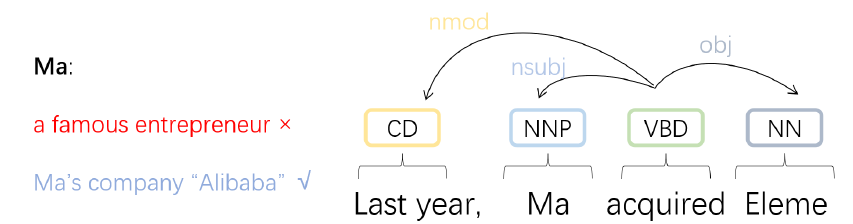
Figure 1. A metonymy example on the geographical parsing problem. According to linguistic valency in English grammar, the meaning of metonymic entity “Ma” is mainly decided by the root of the sentences, i.e., the verb “acquired”. Dependency relations are the basis of understanding